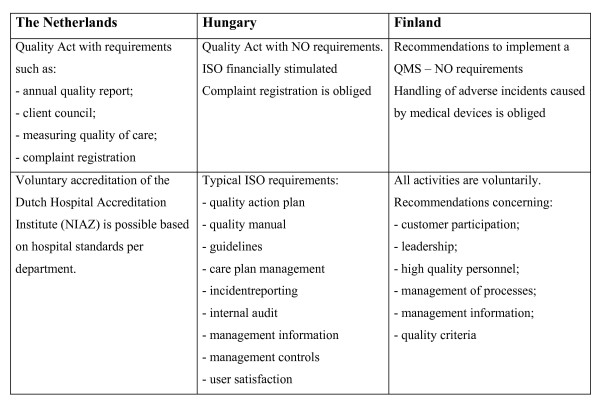
QM-activities obliged by law (The Netherlands), financial stimulation (Hungary), recommendations (Finland)